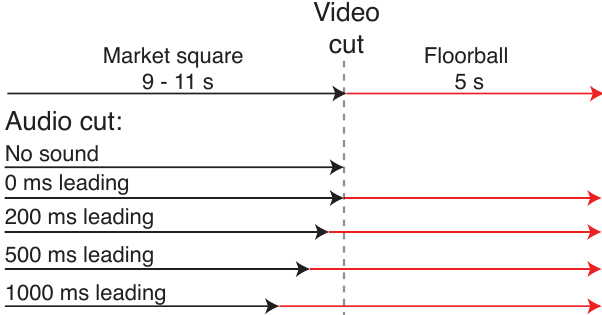
Figure 3 . Structure of one trial. The Market square scene was visually displayed for 9, 10 or 11 seconds, after which the vi- sual scene was cross-faded to the Floorball scene with a 10 ms cross-fade time. The sound scene was cross-faded similarly with a 10 ms cross-fade time with 4 different lead times in relation to the visual cross-fade. There was also a no sound condition where there was silence during the floorball seg- ment. The task was to detect the ball in the game of floorball and press a button when the detection was